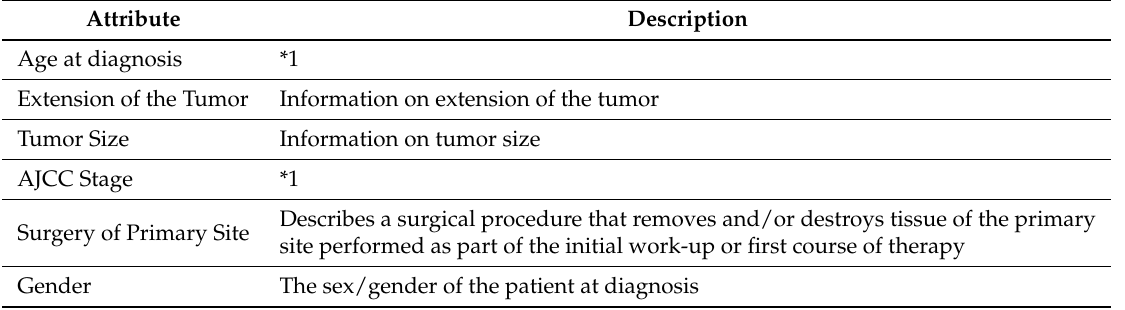
Table 5. Attributes obtained by attribute selection and used for rectal cancer models.